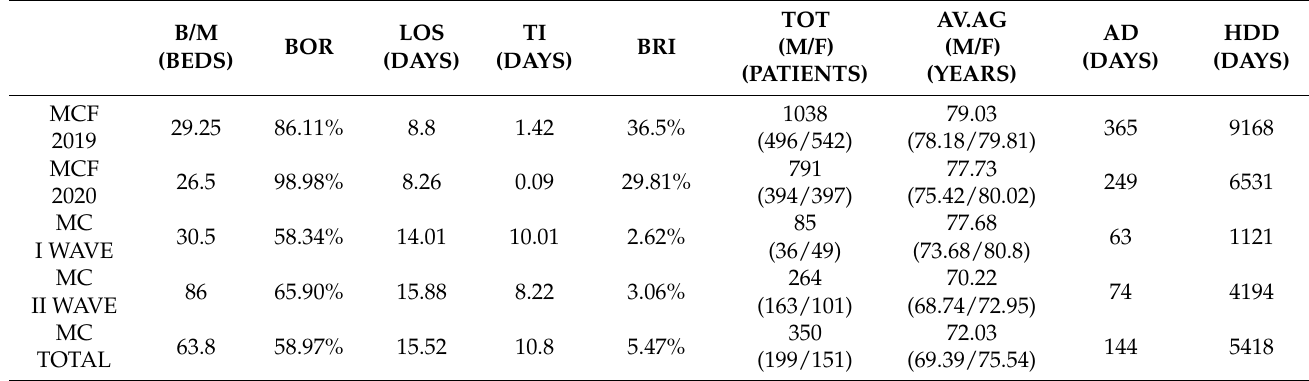
Table 1. Results. B/M: beds per month average value; BOR: bed occupancy rate, LOS: length of stay, TI: turnover index; BRI: bed rotation index. TOT: total number of patients; M: male, F: female, AV.AG: average patient age; AD: activity days